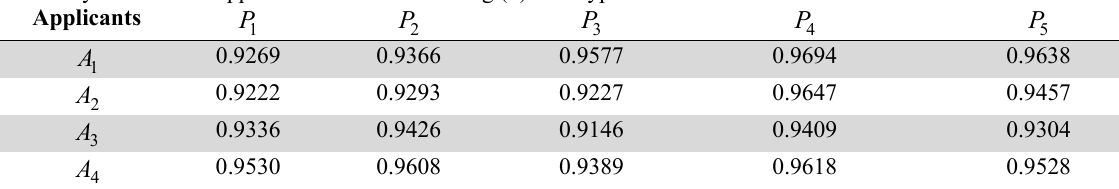
Similarity measure of Applicants vs. Positions using (5) and Type-3 score function